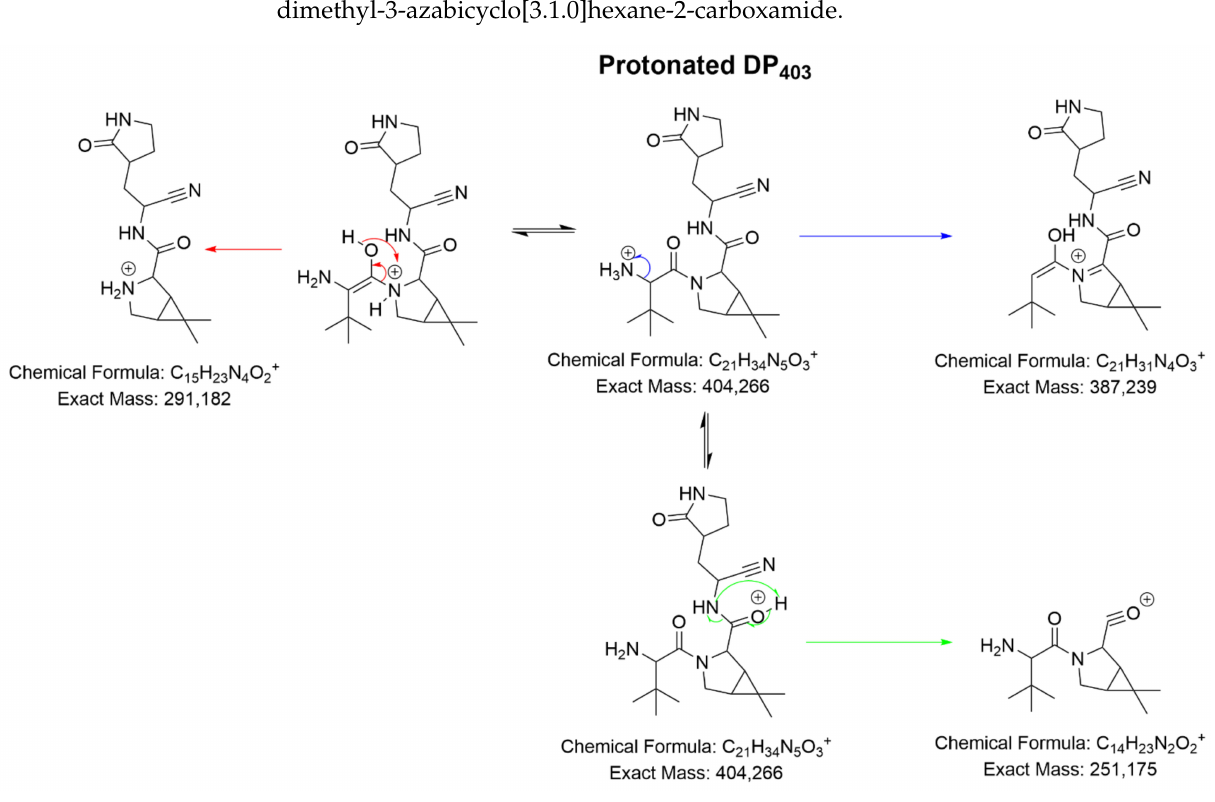
Figure 4. Proposed fragmentation pattern of protonated DP 403 ([DP 403 +H] + ).